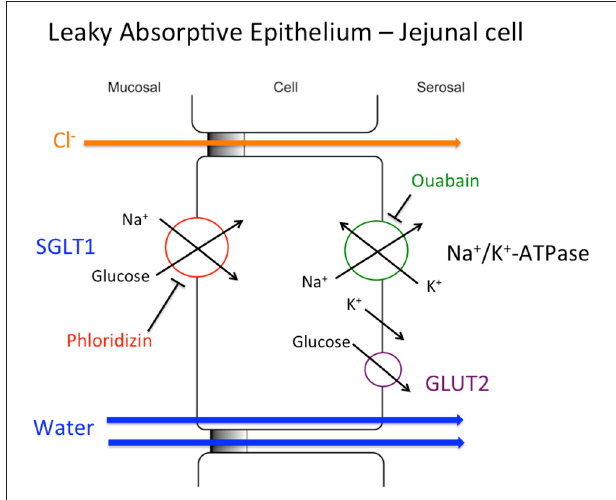
FIGURE 2 | Cellular model of the coupled Na + -glucose cotransporter. The details of this cellular model are given in the